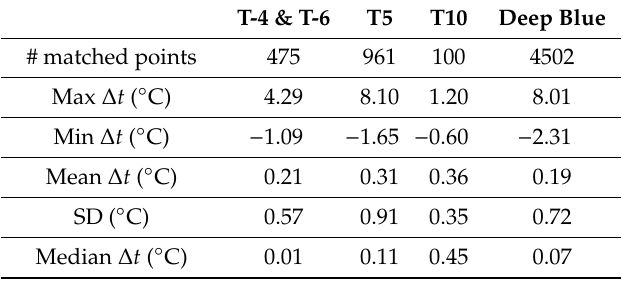
Table 3. ∆ t (XBT-Argo) for each XBT type involved. Depth: 0–100 m ( ± 7 days).